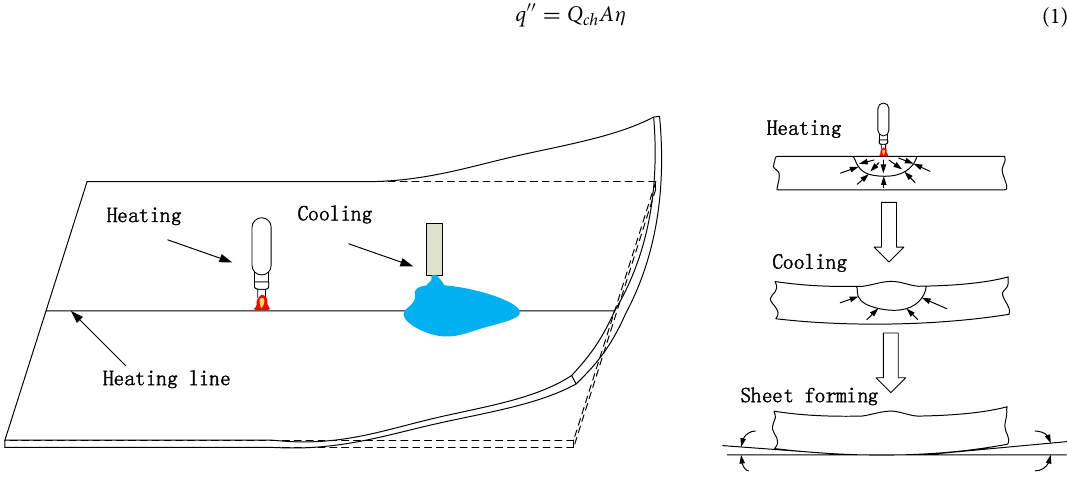
Figure 1. Principle of line heating and